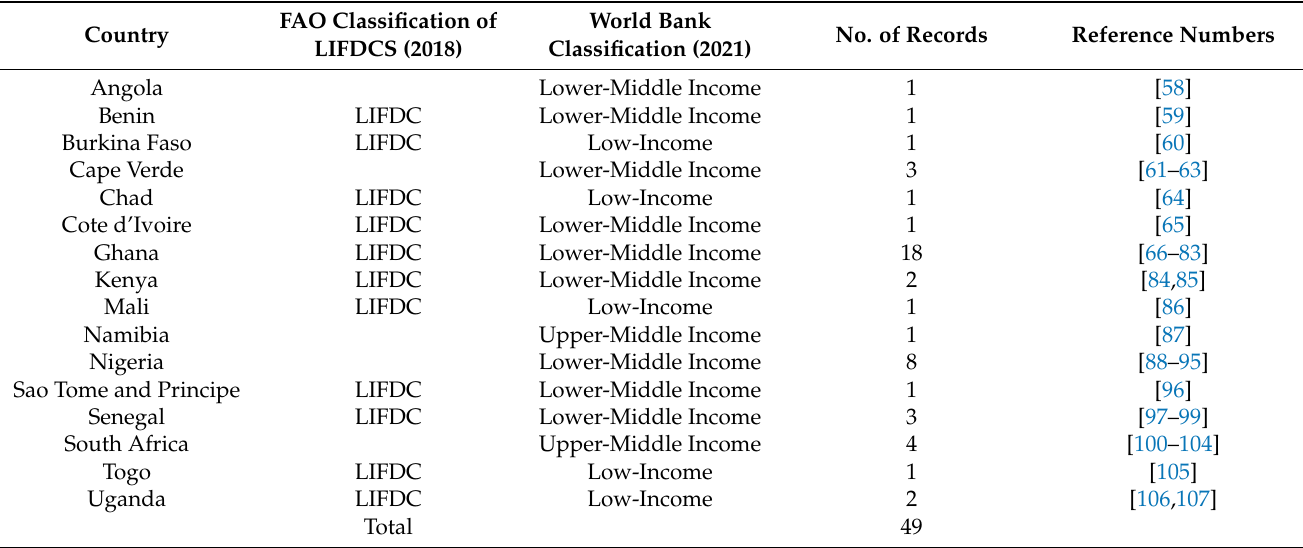
Table 1. Summary of Evidence of fish in SFPs in SSA countries, including FAO classification of Low-Income Food Deficit Countries (LIFDCs) and World Bank country classifications by